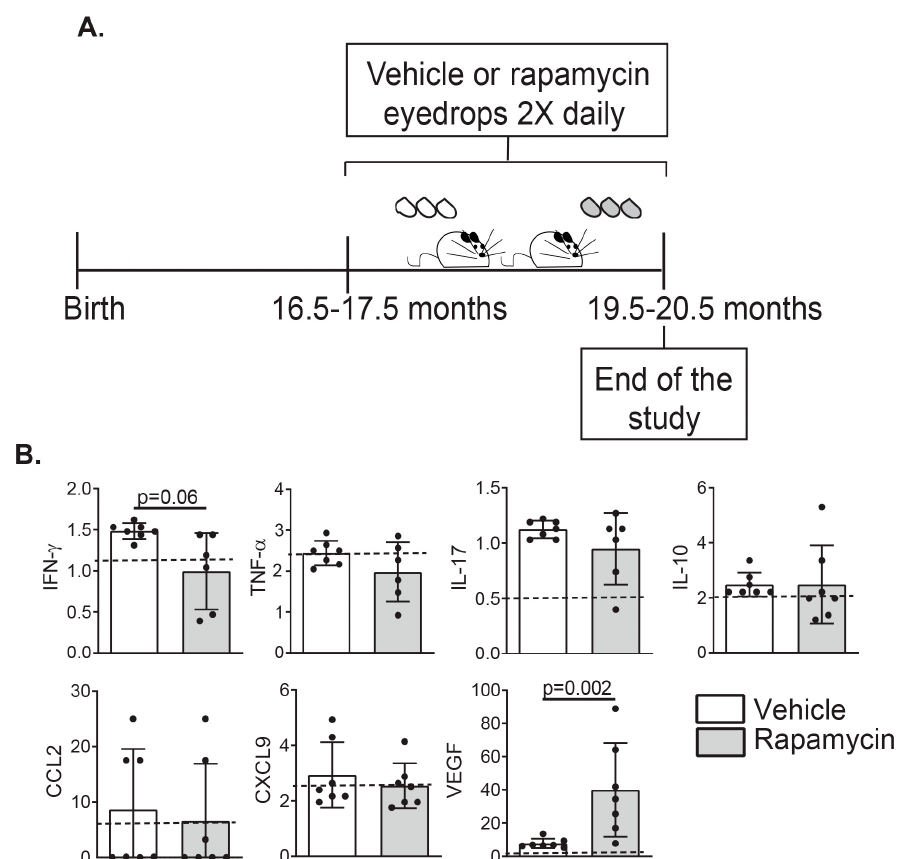
Figure 2. Schematic of the experimental set-up and immunological profile in the tears of the aged mice, and changes after treatment with Rapamycin eyedrops. ( A ) C57BL / 6 mice aged about 17 months were instilled either with empty micelles or rapamycin BID for three months, when they were harvested to collect the tissues for further evaluation. ( B ) Tear washings were collected from the aged mice at harvesting and the levels of pro-inflammatory cytokines, chemokines, and VEGF-A in tears were evaluated using multiplex Luminex ( n = 6–7 / group, error bars indicate the standard deviation (SD) of the mean, Mann–Whitney test). The discontinuous line indicates the detection limit of the assay.